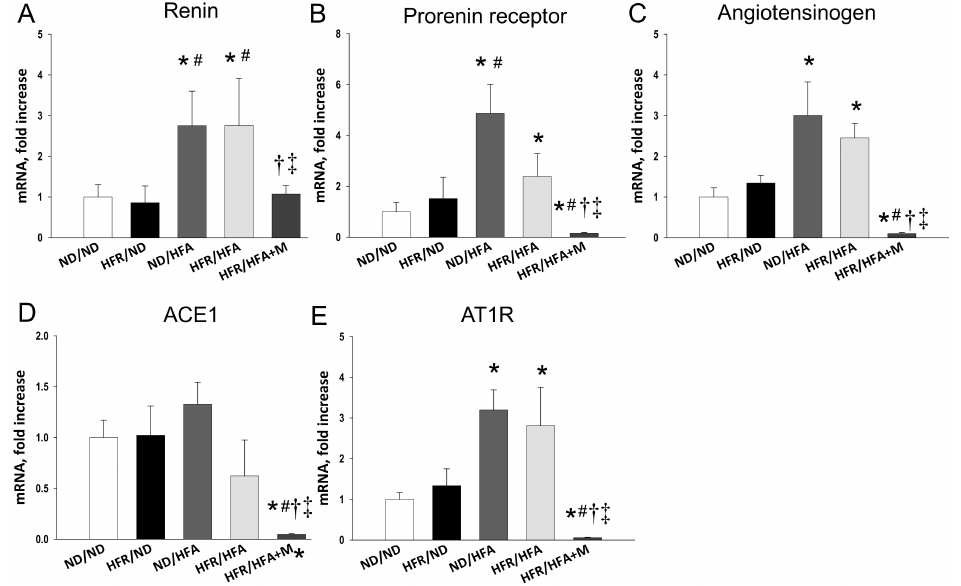
Figure 5. Effect of maternal and post-weaning high-fructose (HFR), post-weaning high-fat (HFA) intake, and metformin (M) on mRNA expression of ( A ) Renin ( Ren ); ( B ) Prorenin receptor ( C ) Angiotensinogen; ( D ) Angiotensin-converting enzyme-1 (ACE1); and ( E ) Angiotensin II type I receptor (AT1R) in male offspring kidneys at 12 weeks of age. * p < 0.05 vs. ND/ND, # p < 0.05 vs. HFR/ND, † p < 0.05 vs. ND/HFA, ‡ p < 0.05 vs.